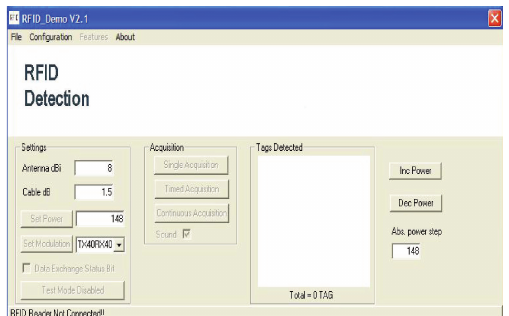
F 12: e customized GUI of the application for the UHF reader